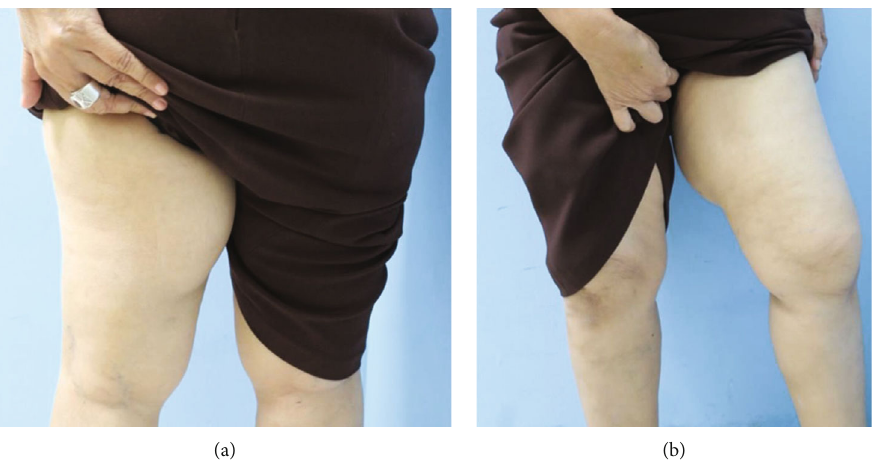
Figure 1: Demonstrated mass at left thigh: (a) posterior view, (b) front view.